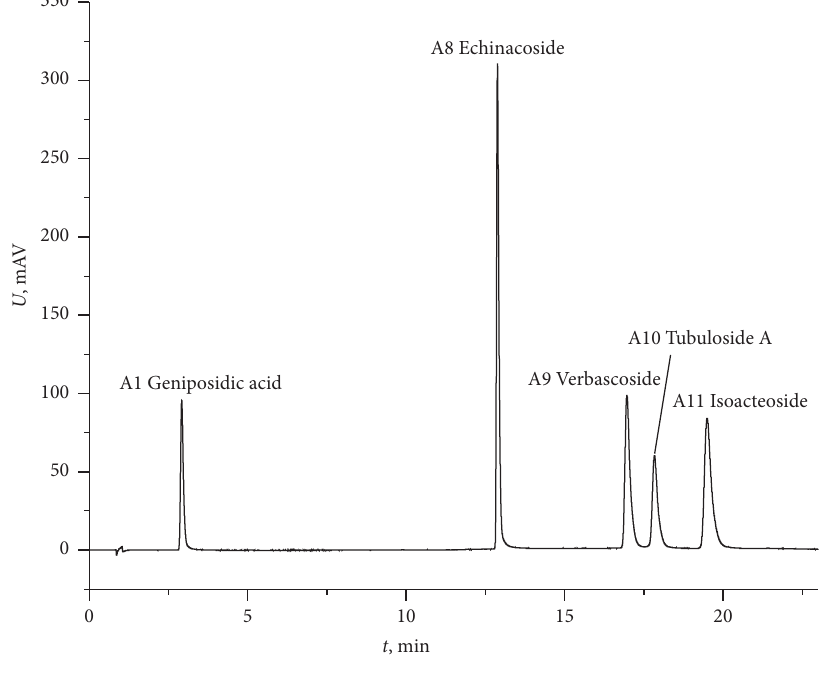
Figure 2: HPLC fngerprints of standard